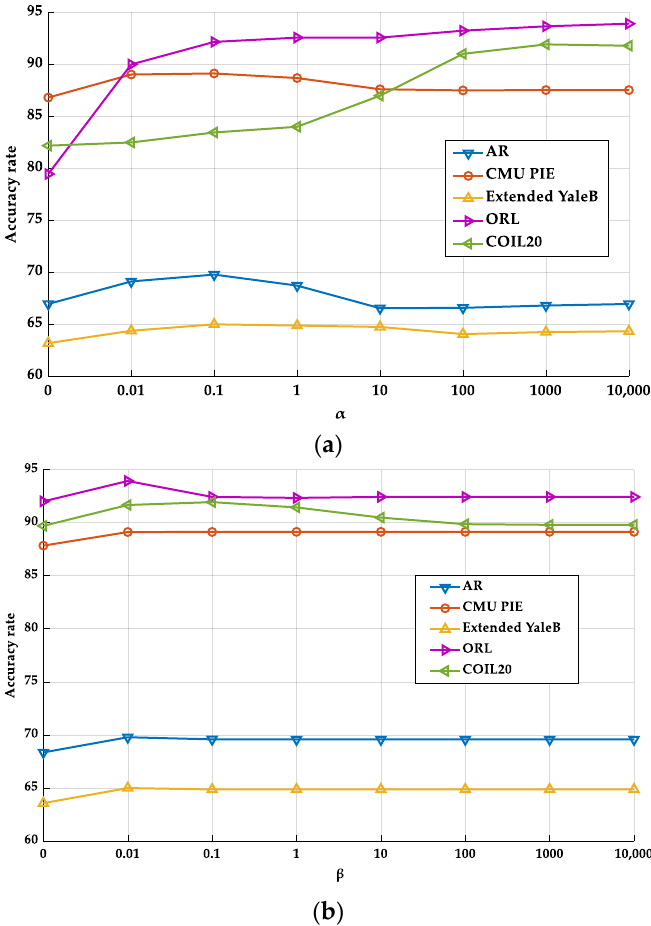
Figure 4. The classification accuracy rate of different parameter values: ( a ) parameter α ; ( b ) parameter β .